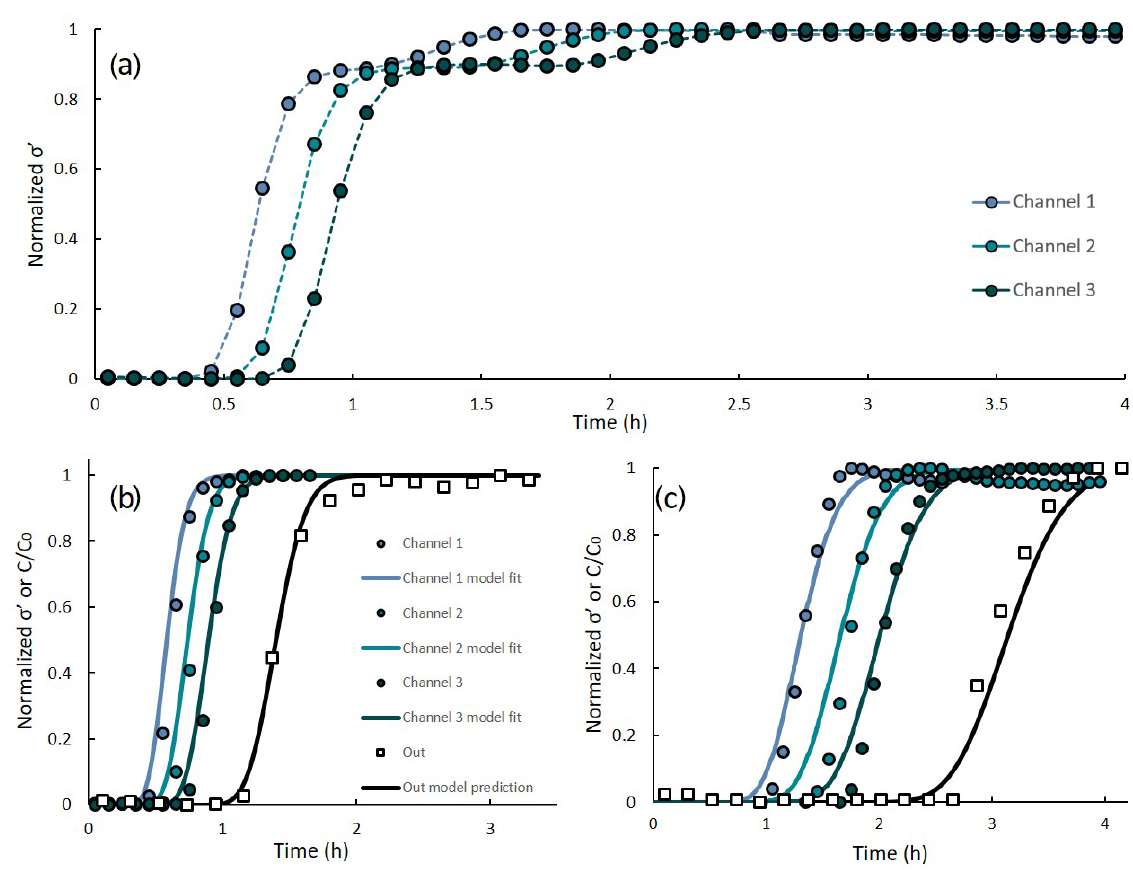
Figure 4. (a) Real conductivity at 1Hz vs. time at three locations, (b) model fit to the σ (cid:48) -based initial BT and model prediction for the non-reactive species at the outflow compared to their measured concentration and (c) model fit to the σ (cid:48) -based secondary BT and model prediction for the reactive fraction of Ca 2 + ions (calculated as outflow Ca 2 + minus its “non-reactive fraction”) compared to its measured